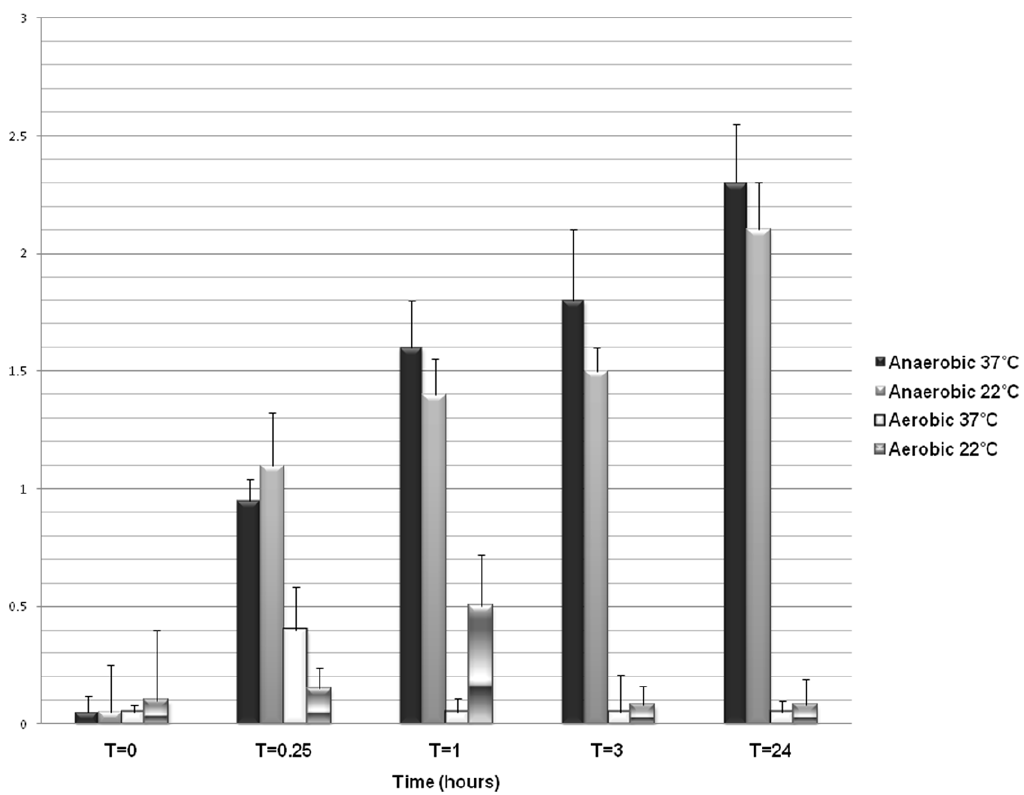
Figure 3. Effect of anaerobic conditions and increased temperature on ethanol susceptibility of dormant and germinating spores in solution. An epidemic NAP1/BI strain of Clostridium difficile spores was incubated in germination solution either aerobically or anaerobically at 22 u C or 37 u C. Mean reduction (log 10 colony-forming units) in viable spores was assessed after exposure to 90% ethanol at several time points over 24 hours by enumerating serially diluted plate cultures.